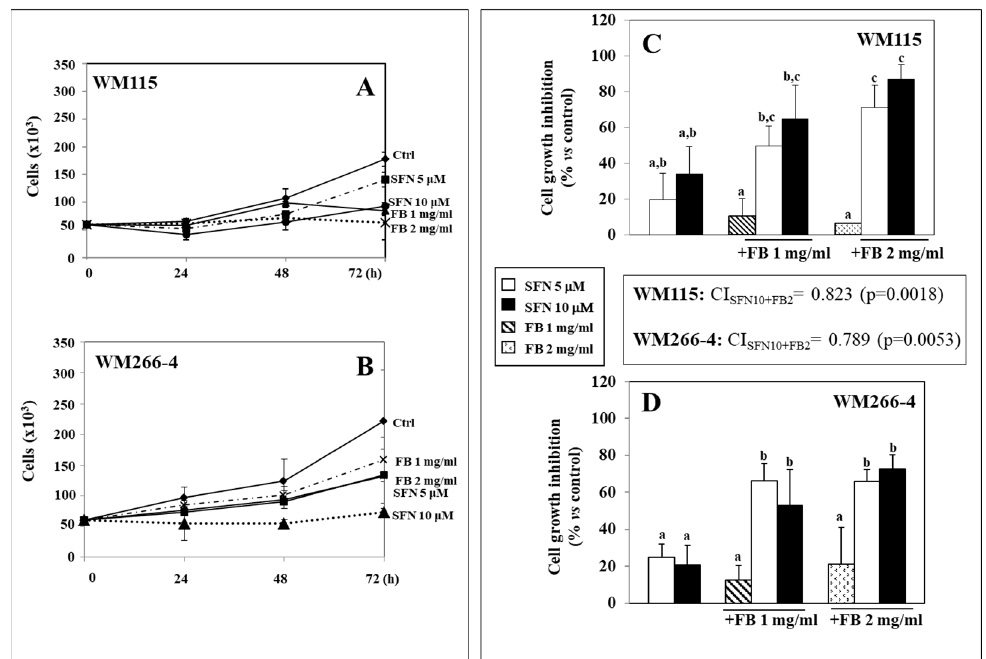
Figure 1. Effect of increasing concentrations of sulforaphane (SFN) (5 and 10 μ M) and Fernblock ® XP Figure 1. E ff ect of increasing concentrations of sulforaphane (SFN) (5 and 10 µ M) and Fernblock ® (FB) (1 and 2 mg/mL) for different periods of time (24–72 h) in WM115 ( A ) and WM266-4 ( B ) human XP (FB) (1 and 2 mg / mL) for di ff erent periods of time (24–72 h) in WM115 ( A ) and WM266-4 ( B ) melanoma cells. In panels ( C ) and ( D ), the effect of a 24 h combined treatment with SFN and FB in human melanoma cells. In panels ( C , D ), the e ff ect of a 24 h combined treatment with SFN and FB in WM115 ( C ) and WM266-4 ( D ) cells. In panels ( C ) and ( D ), values not sharing the same superscript WM115 ( C ) and WM266-4 ( D ) cells. In panels ( C , D ), values not sharing the same superscript letter are letter are significantly different ( p < 0.05, One-way ANOVA followed by Tukey’s test). In the box significantly di ff erent ( p < 0.05, One-way ANOVA followed by Tukey’s test). In the box between panels between panels ( C ) and ( D ) is shown the combination index (CI) obtained by treating WM115 and ( C , D ) is shown the combination index (CI) obtained by treating WM115 and WM266-4 melanoma cells WM266-4 melanoma cells with the highest concentrations of SFN (10 μ M) and FB (2 mg/mL) alone with the highest concentrations of SFN (10 µ M) and FB (2 mg / mL) alone and in combination for 24 h. and in combination for 24 h. The interaction was considered significant when p < 0.05 (2 × 2 factorial The interaction was considered significant when p < 0.05 (2 × 2 factorial ANOVA) (see Materials and ANOVA) (see Materials and Methods section for details). Methods section for